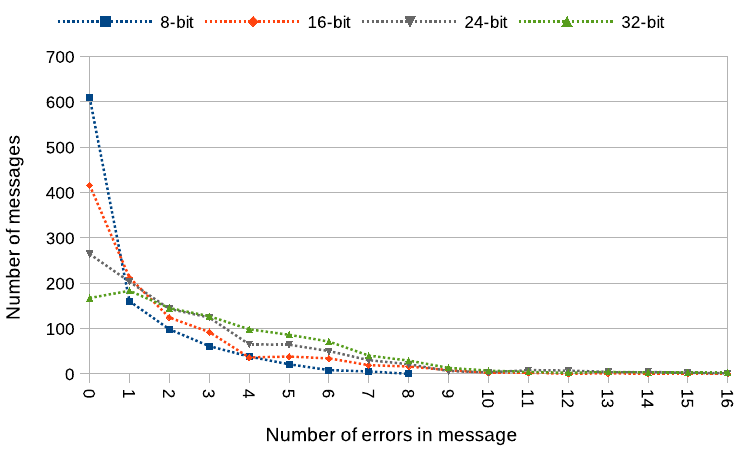
Figure 15. Measurement of the packet error rate (IEEE 802.11n; One-informed).